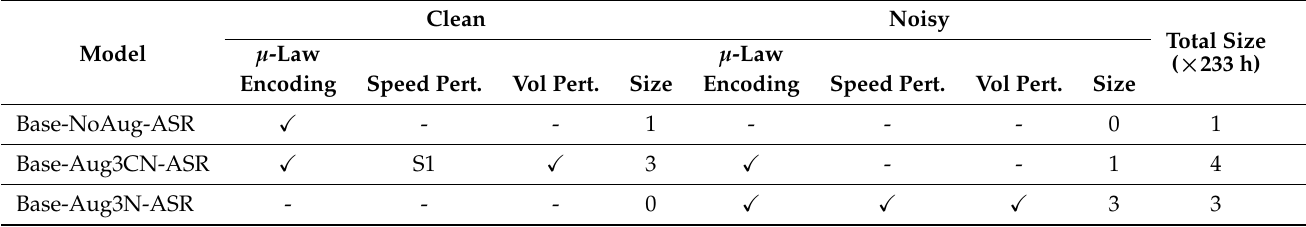
Table 2. Dataset for training baselines. Notations: S1 = speed perturbation (0.9, 1, 1.1),